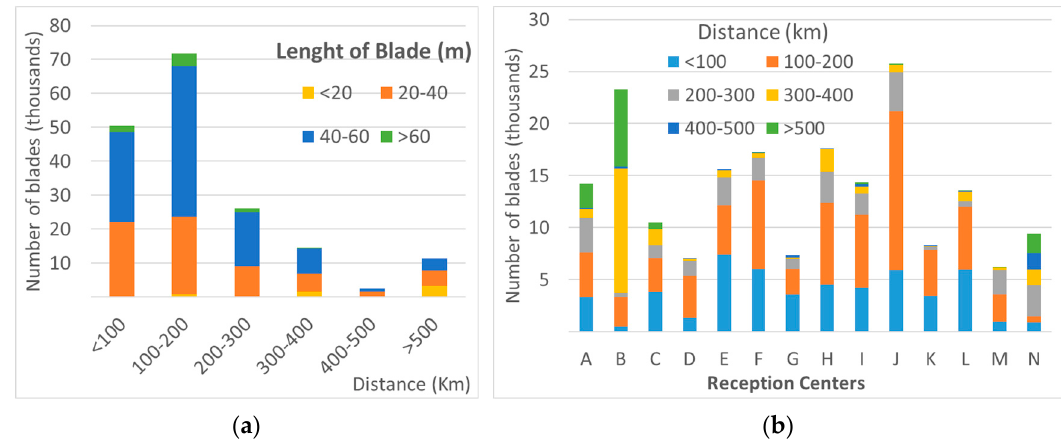
Figure 14. Blade transport distance to corresponding US—EoL center classified by ( a ) blade length (m) and ( b ) EoL reception centers.